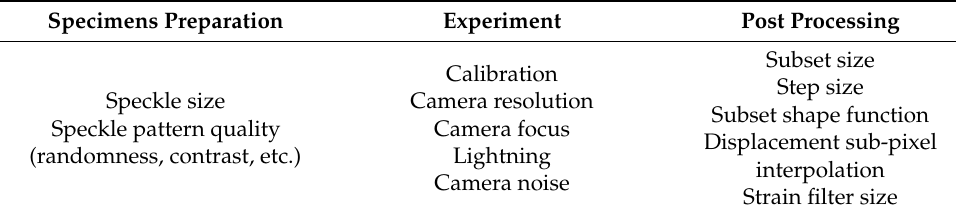
Table 1. DIC parameters determining the measurements accuracy. Specimens